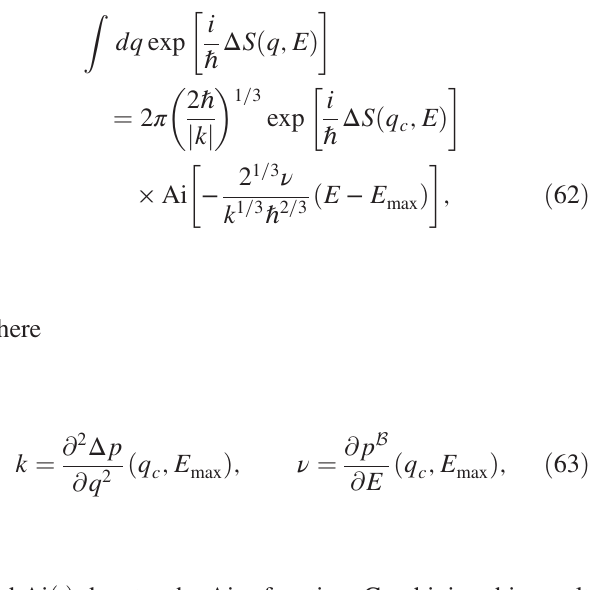
FIG. 7. Solid blue lines depict the surfaces A ¼ A τ (as in Fig. 1). Dashed red lines are energy shells B of H indicate the points of tangency between A and B at E and E , respectively. (a) In the absence of symmetries, we generically expect min max a single tangent point at E and E . (b) For the Hamiltonian that we study numerically, Eq. (24), the symmetry of the quartic min max potential implies that both A and the energy shells B are symmetric under ð q; p Þ → ð − q; − p Þ ; thus, points of tangency come in symmetry-related pairs.